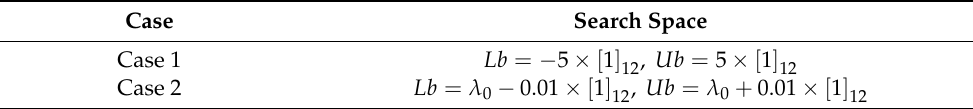
Table 8. Search space of two cases.